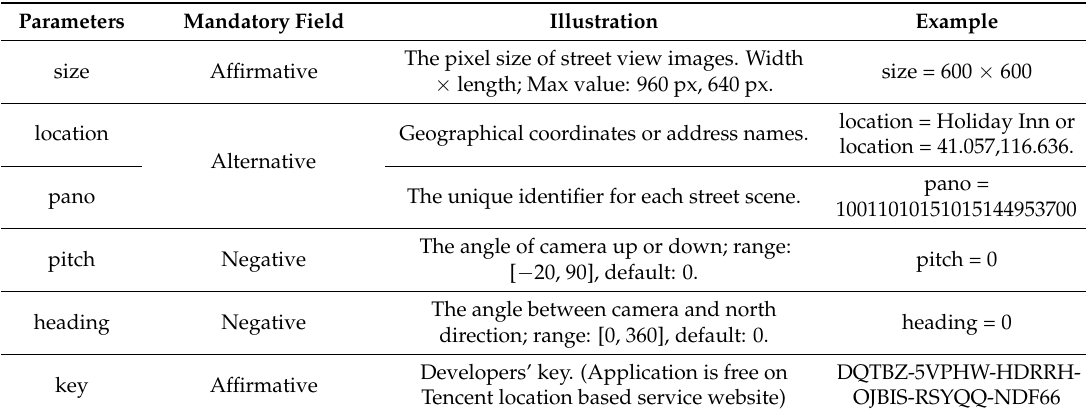
Table A2. Parameters of Tencent Static Image